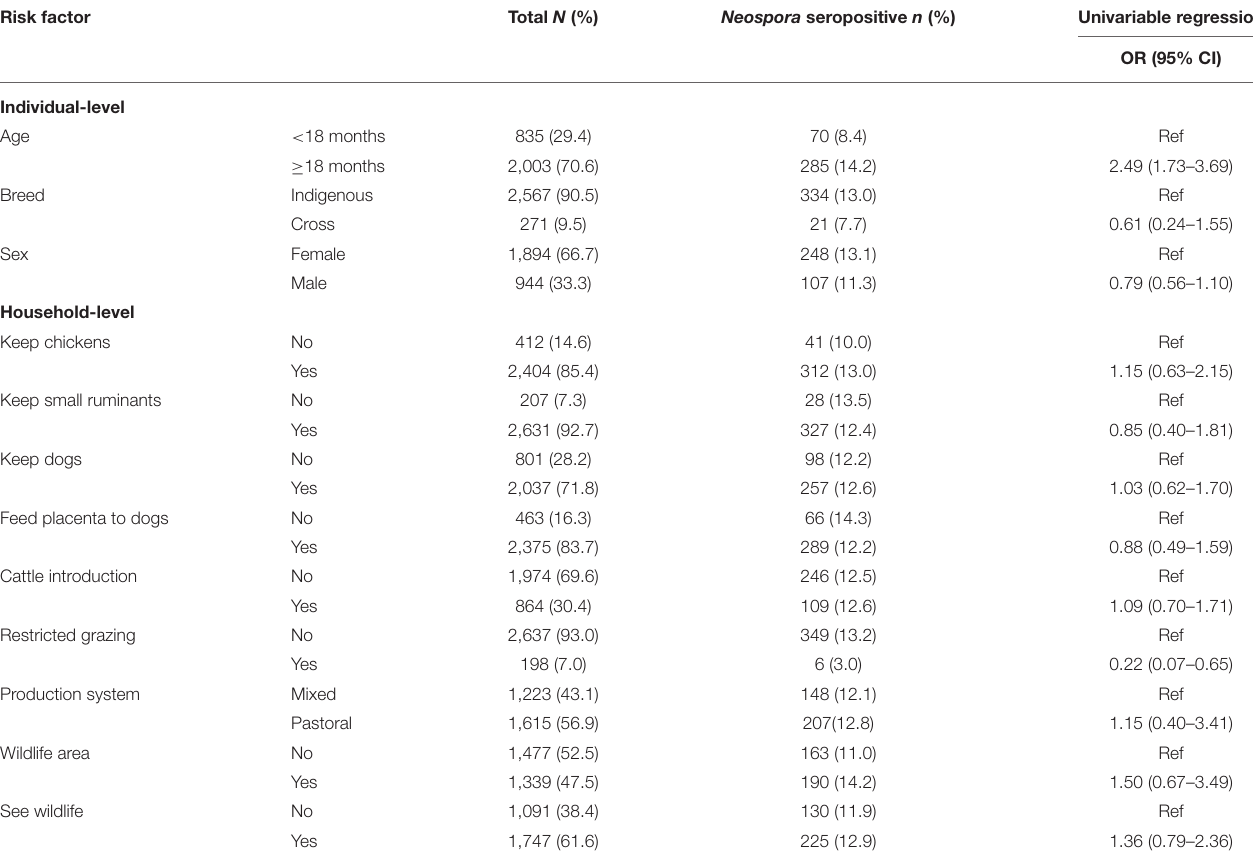
TABLE 1 | Individual and household-level characteristics of categorical variables and their relationship with the seroprevalence of Neospora caninum in cattle in northern Tanzania. Risk